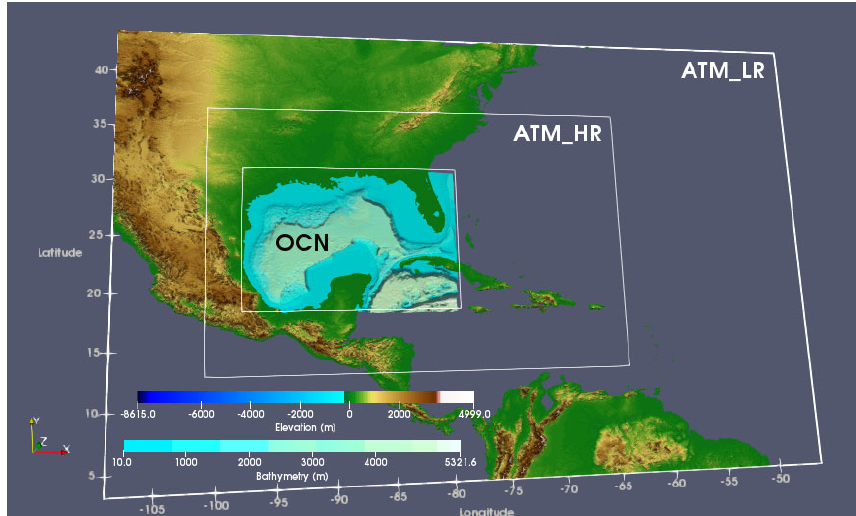
Figure 8. Domain for the RegESM simulations with topography and bathymetry of the region. The solid white boxes represent boundaries of the atmosphere (both outer and inner) and ocean model